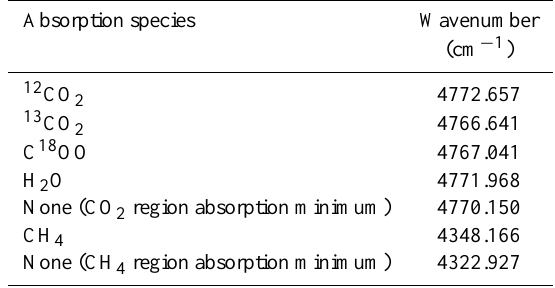
Table A1. Selected absorption